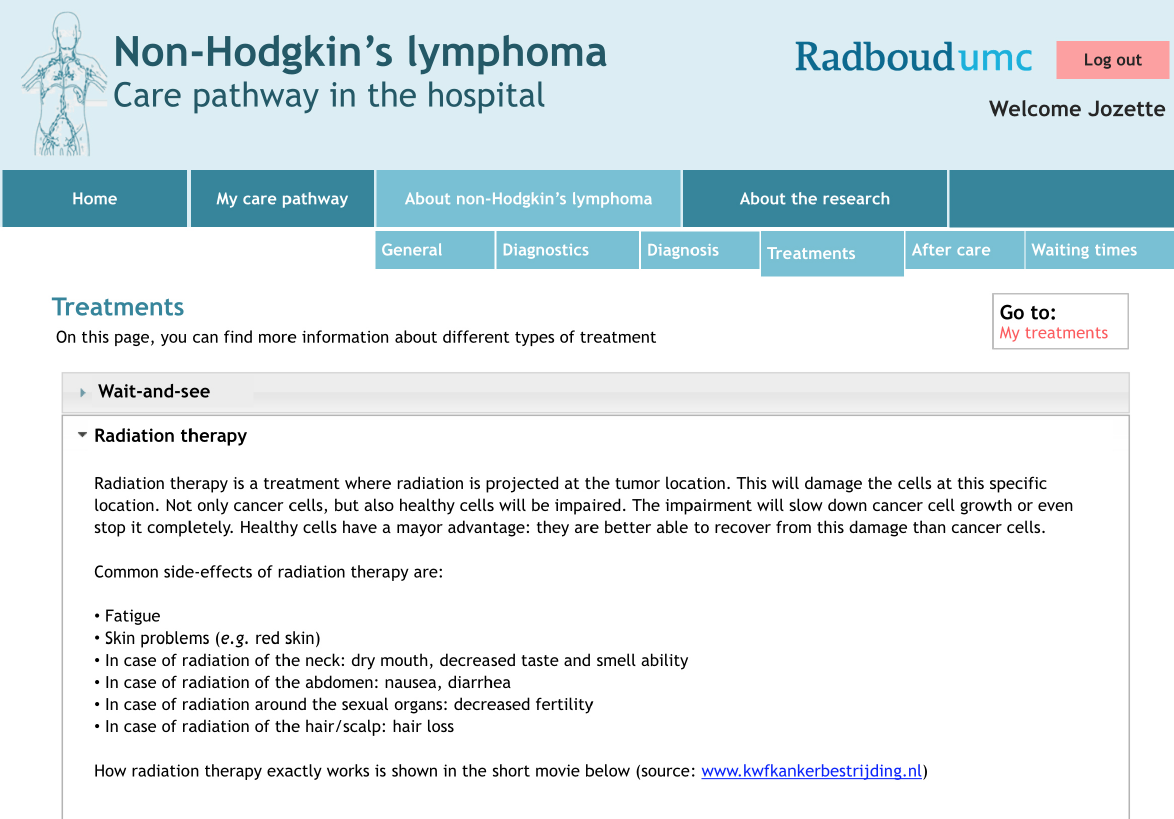
Figure 2. Example of informative section of the e-tool. Original is in